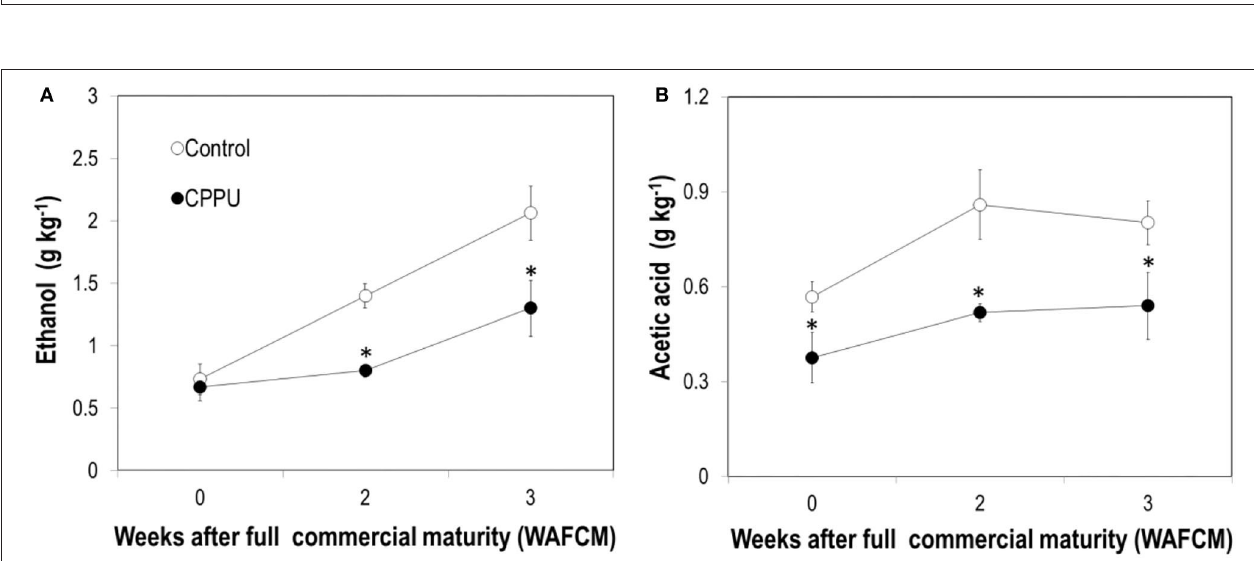
FIGURE 7 | Effect of preharvest application of CPPU on changes in ethanol (A) and acetic acid (B) in the aril of the ripe “Feizixiao” litchi fruit remained on tree. Vertical bar at each data point stands for standard error ( n = 5). *Indicates significant difference between CPPU treatment and the control at p < 0.05, Student’s t -test.